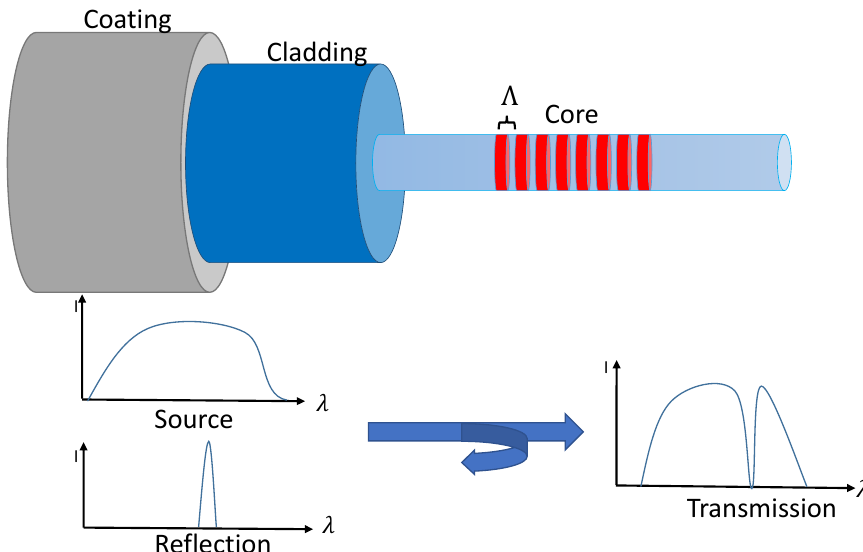
Figure 1. Structure of a Fibre Bragg Grating and its measurement